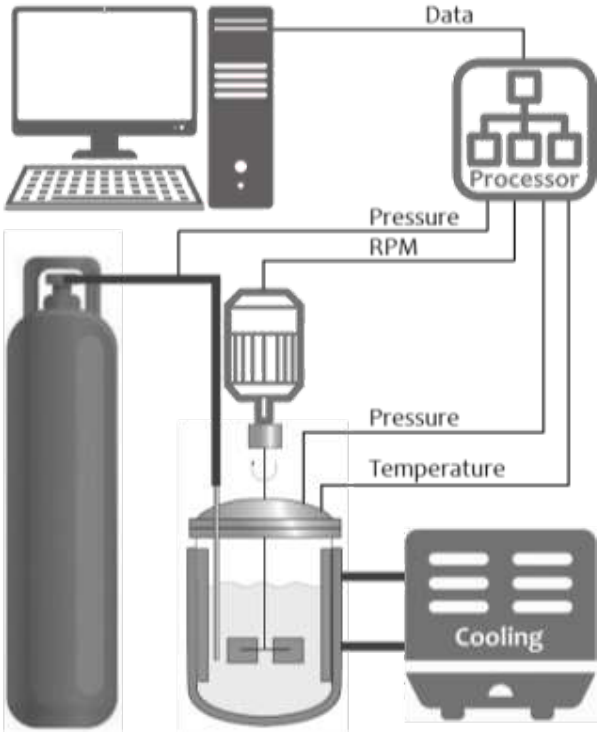
Figure 1. A typical apparatus used for hydrate formation